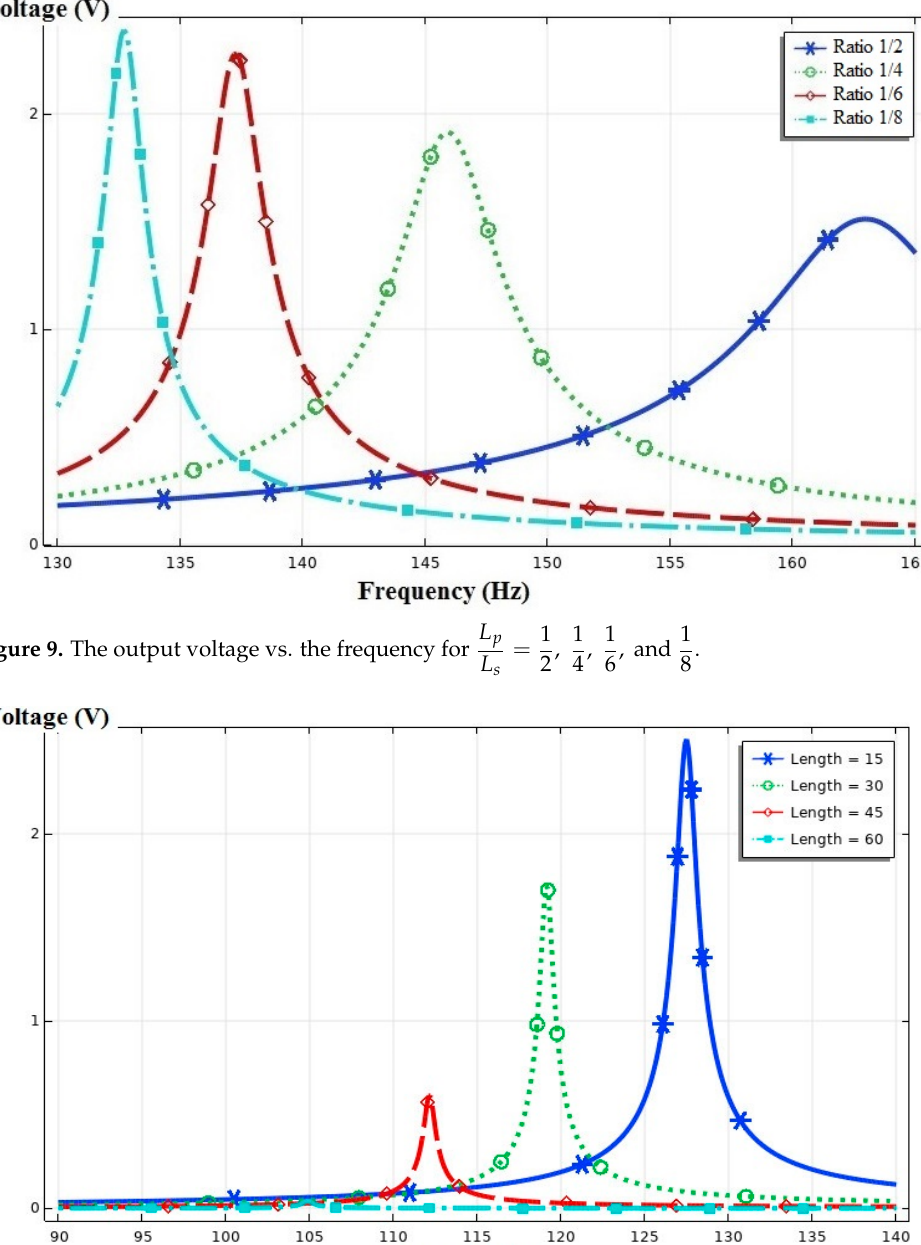
Figure 10. The output voltage vs. the frequency at different distances of the piezoelectric patch from the cantilevered end.